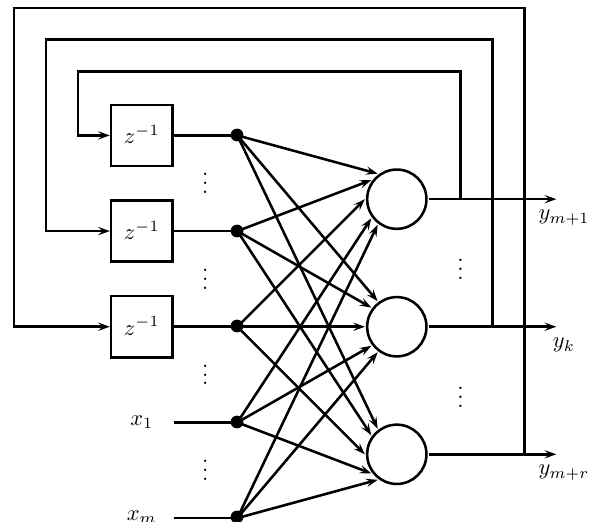
Figure 1. Example of a fully connected recurrent neural network using m inputs, and r process- ing